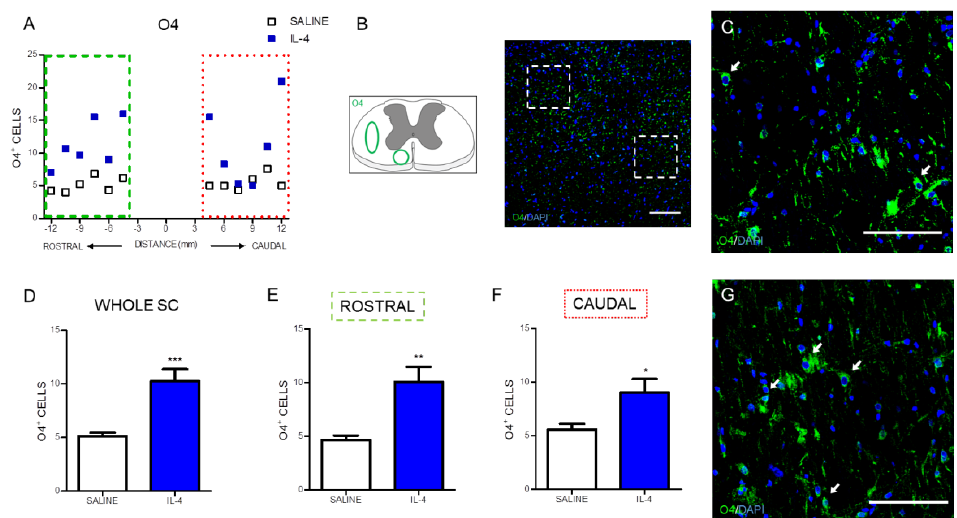
Figure 7. IL-4 treatment increases the number of oligodendrocytes in the injured spinal cord. Distribution of the O4 + cells along the rostrocaudal axis of the spinal cord ( A ); Quantification of O4 + cells in the whole spinal cord revealed a significant increase of oligodendrocytes in IL-4-treated rats ( D ); A significant increase of oligodendrocytes was also observed in the rostral ( E ) and caudal ( F ) regions of the injured spinal cord. Schematic and low-magnification photomicrograph indicating areas where the analyses were performed (dashed lines) ( B ); Representative images of positive staining for oligodendrocytes of saline ( C ) and IL-4 treated ( G ) group. Values shown as mean ± SEM. * p < 0.05; ** p < 0.01; *** p < 0.001. Scale bar = 100 µ m.